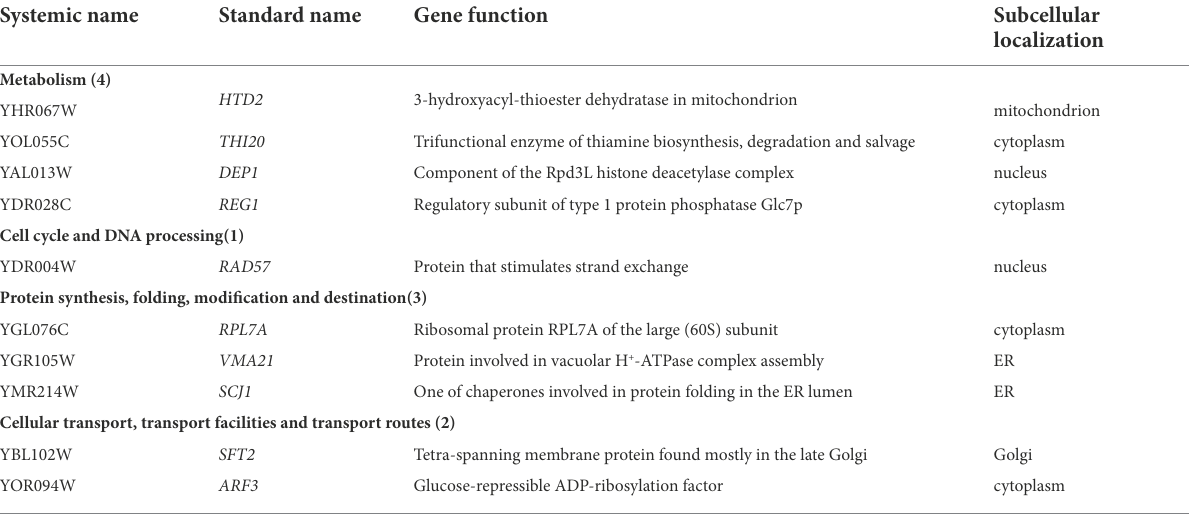
TABLE 2 Localization and function of genes related to Gd-resistance deletion